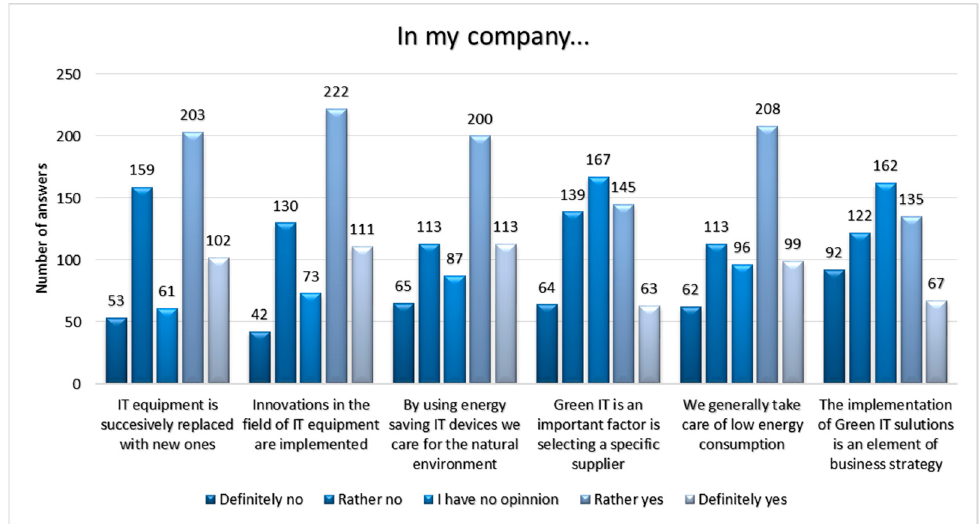
Figure 1. Actions taken in the company. Source: Own study based on survey results.